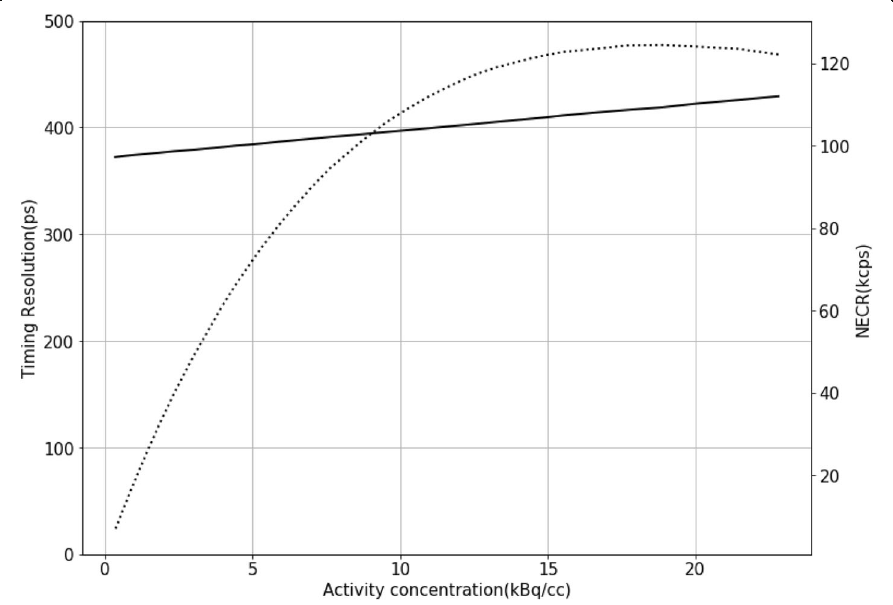
Fig. 4 Timing resolution curve (solid line) in dependency on activity concentration and also plotted NECR curve (dotted line) by using double Y